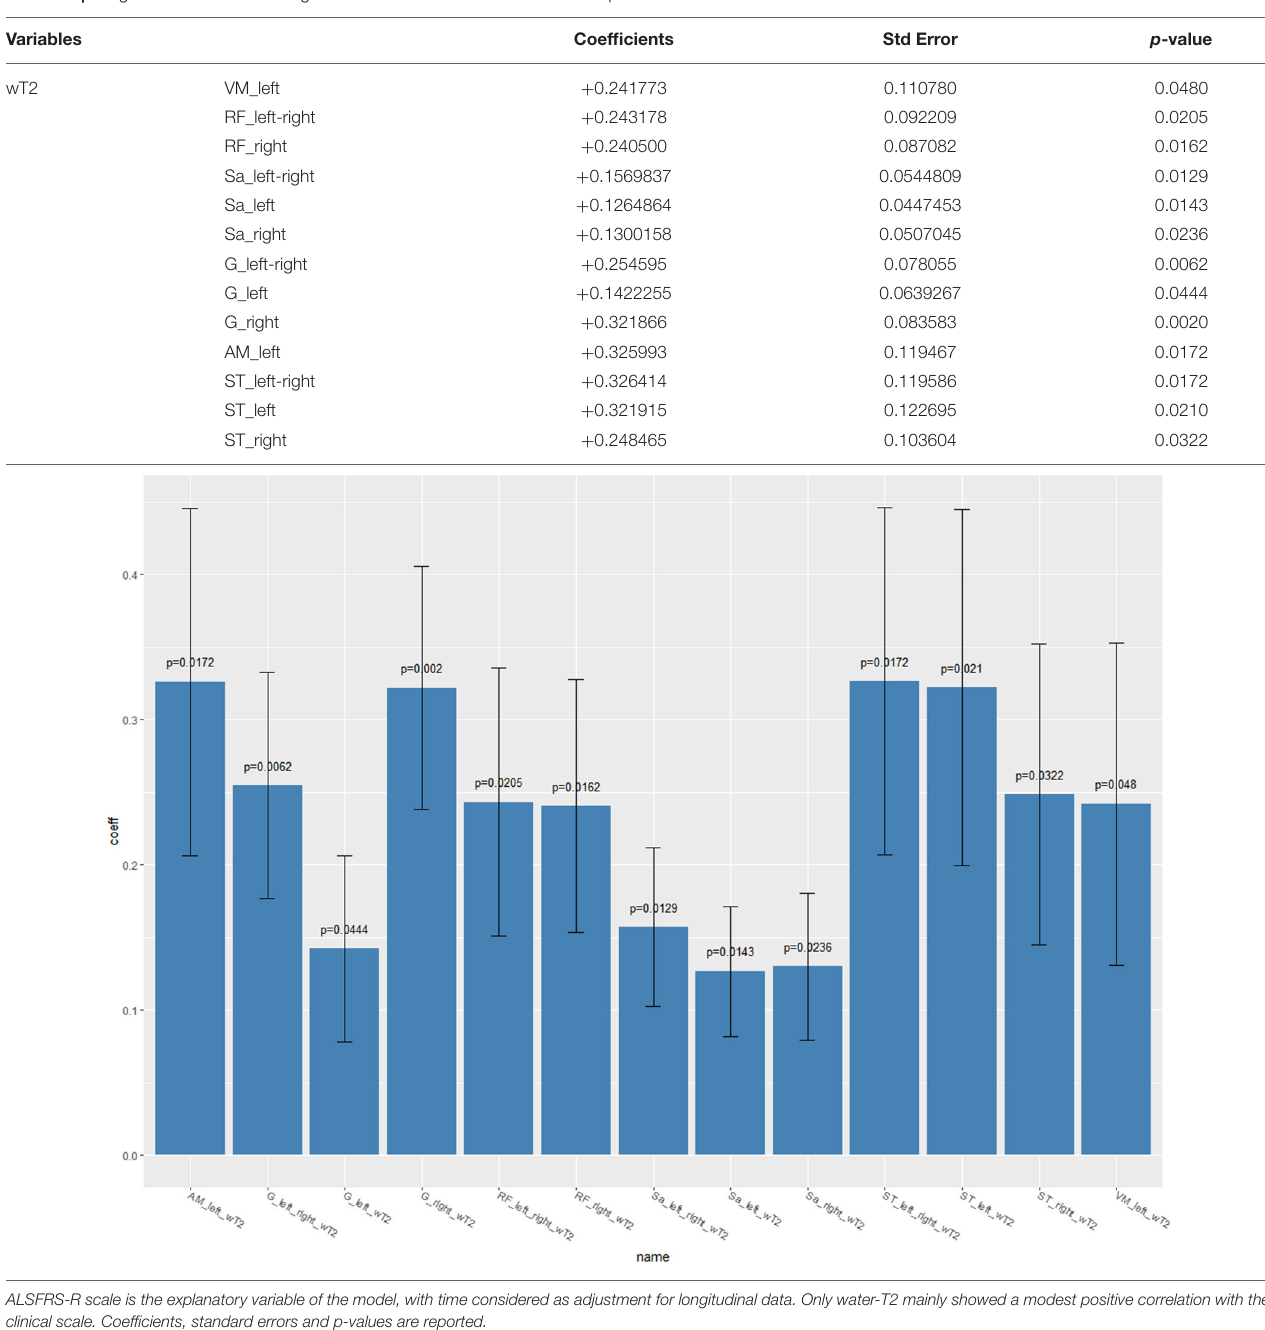
TABLE 4 | Longitudinal correlation of leg subscore of the ALSFRS-R scale with qMRI measures—mixed effects models result.